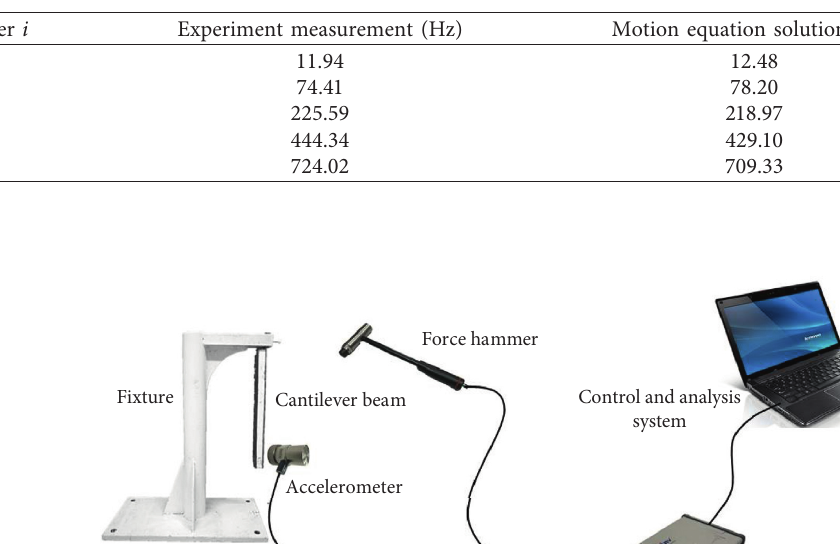
Table 2: Comparison between the modal frequencies of the first five orders of the cantilever beam.